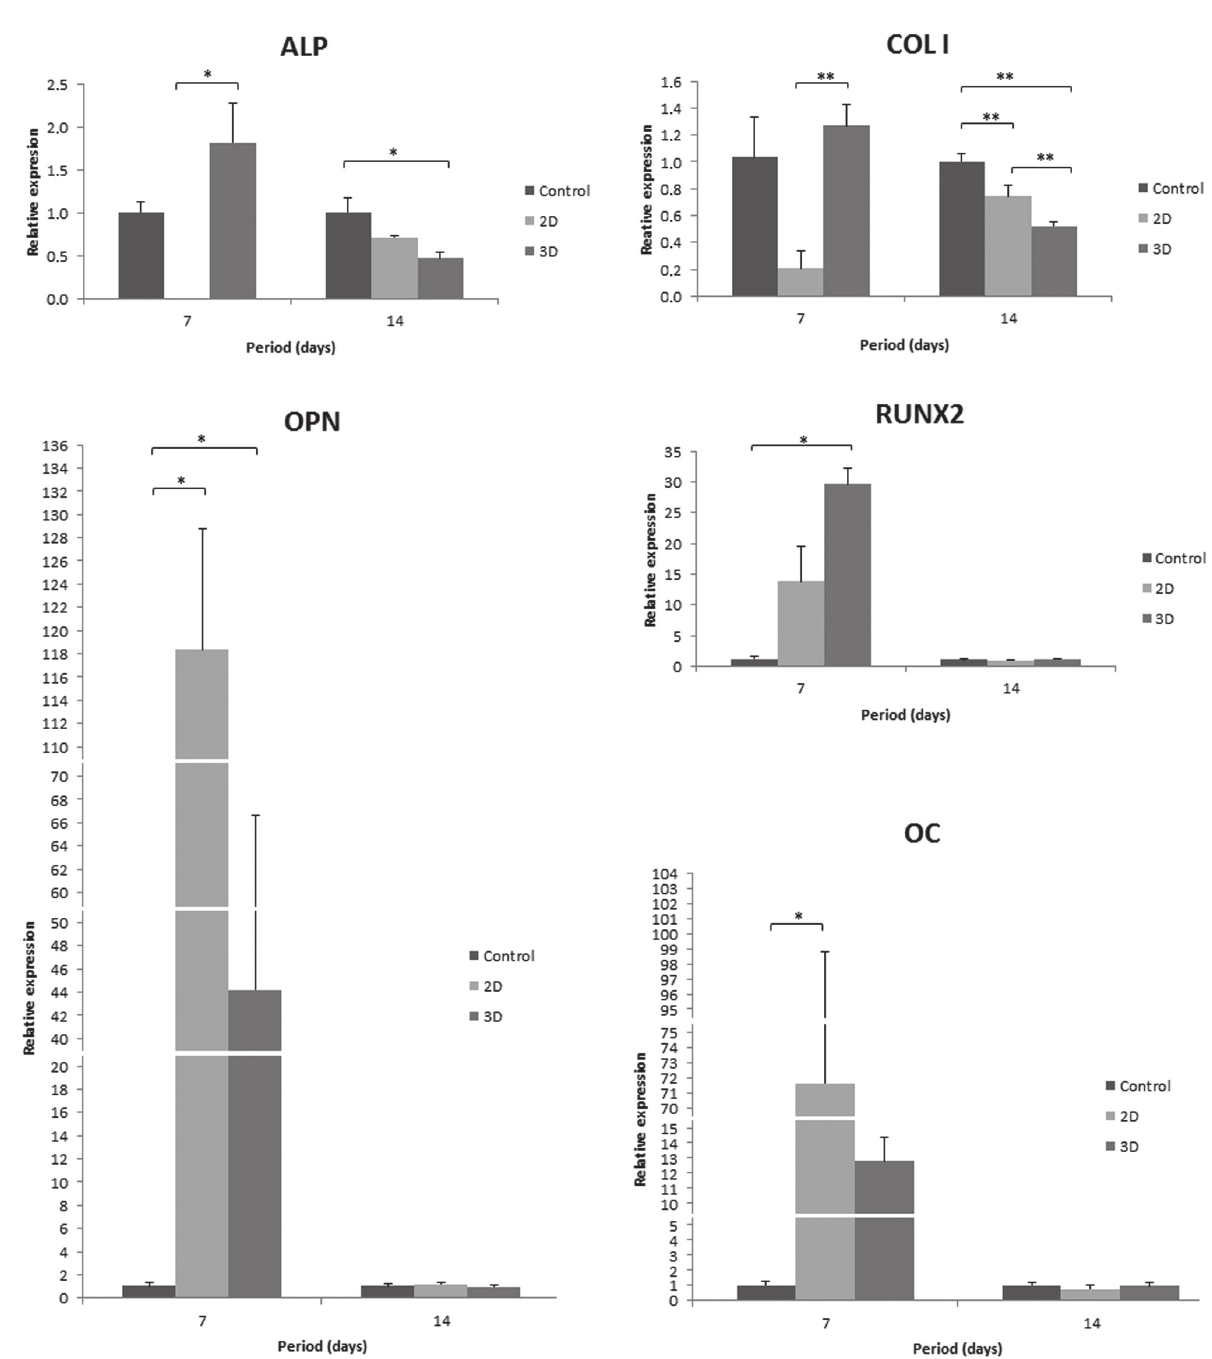
Figure 5- Gene expression of COL I, ALP, RUNX2, OPN and OC in hPDLF cultured on different groups at 7 and 14 days using real-time polymerase chain reaction (PCR). Data were calculated as the relative expression of the target mRNA normalized to β-actin and to control (calibrator) and are reported as mean±SD. *p<0.05 (Kruskal-Wallis – post-test Dunn’s) and **p<0.05 (ANOVA – post-test